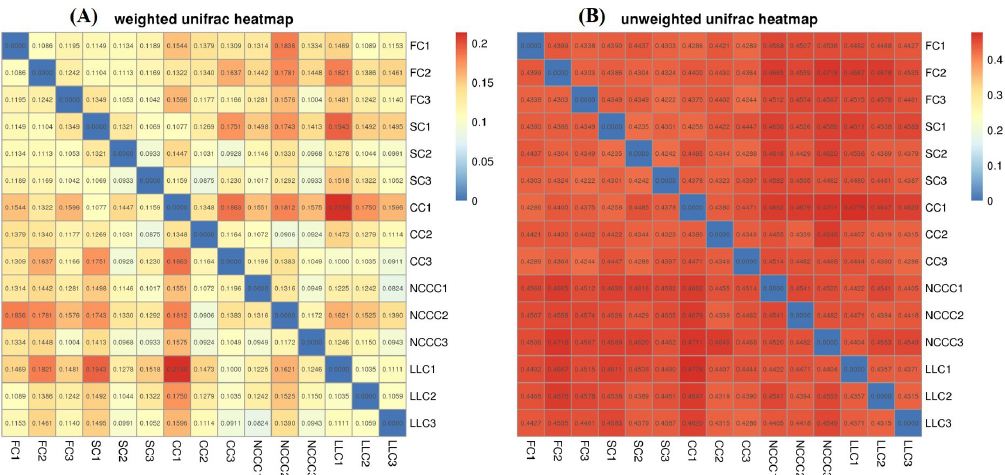
Figure 4. Heatmap based distance matrix of beta diversity analysis using weighted uniFrac ( a ) unweighted uniFrac ( b